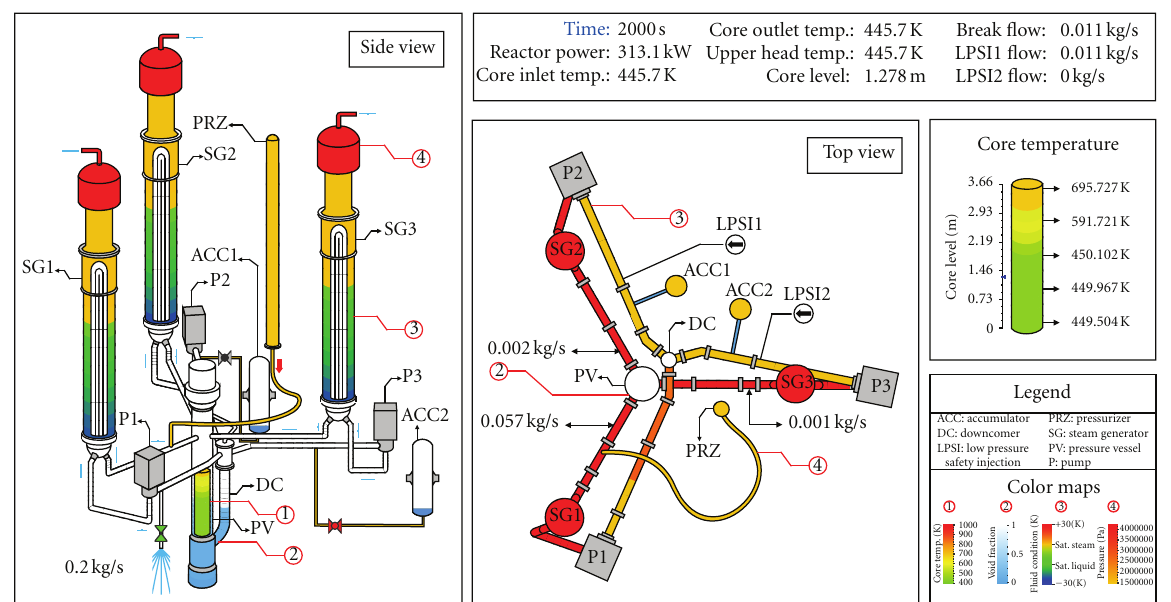
Figure 23: Animation mask for TRACE at time t = 2000 s (core